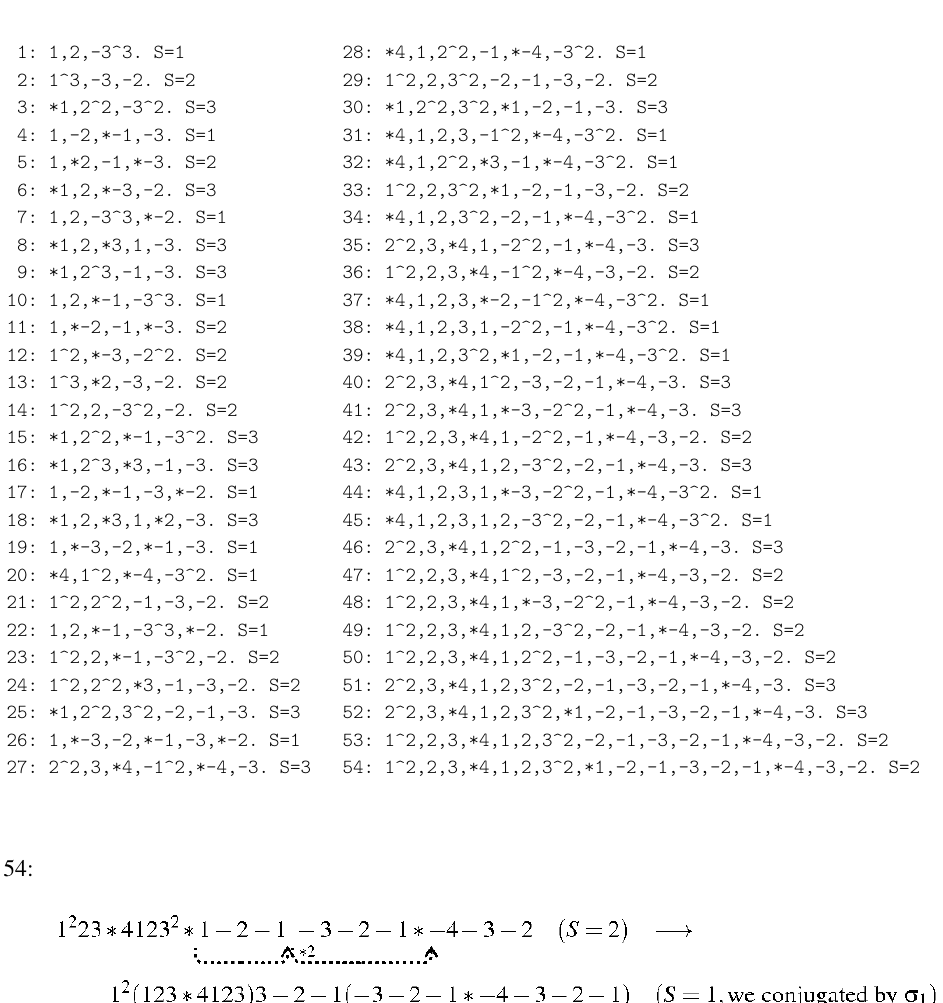
Table 1. The list of 54 patterns that give words of Figure